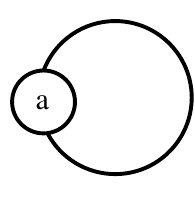
Figure 5 . The modular graph E a .